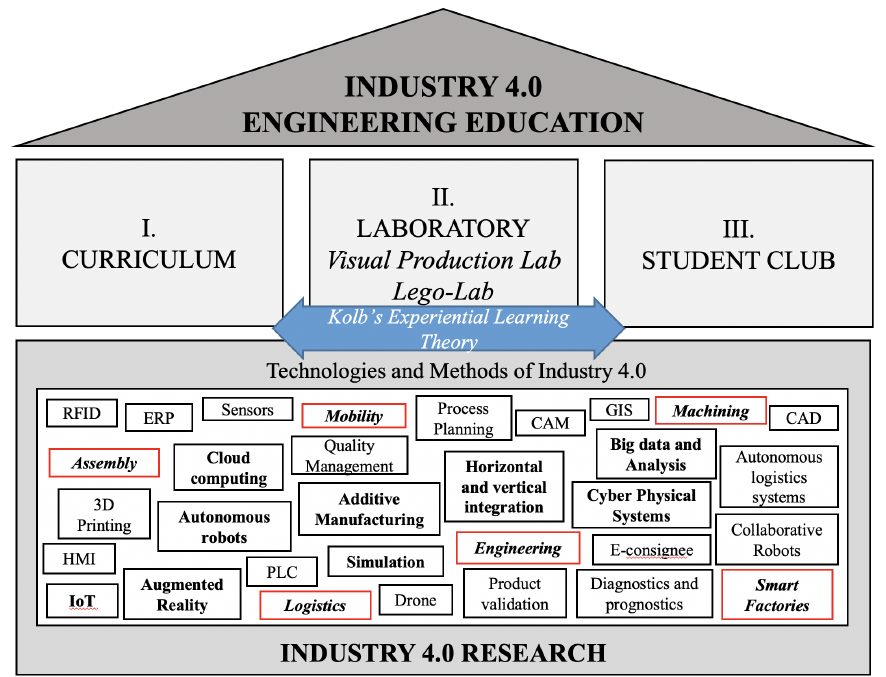
Figure 1. Generic framework of Industry 4.0 engineering